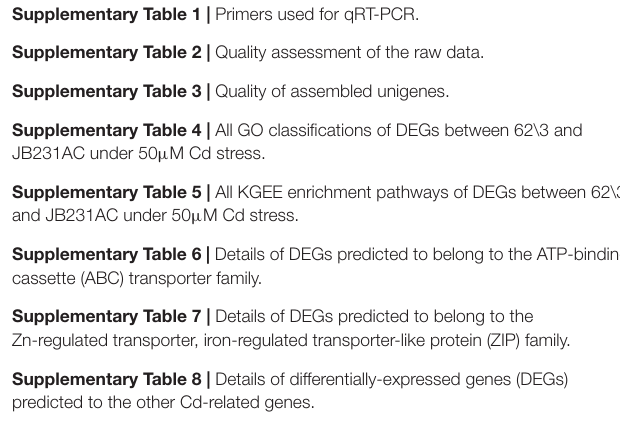
Supplementary Figure 1 | Length distribution of unigenes. Supplementary Figure 2 | Express gene saturation test of RNA-Seq data. Supplementary Table 1 | Primers used for qRT-PCR. Supplementary Table 2 | Quality assessment of the raw data. Supplementary Table 3 | Quality of assembled